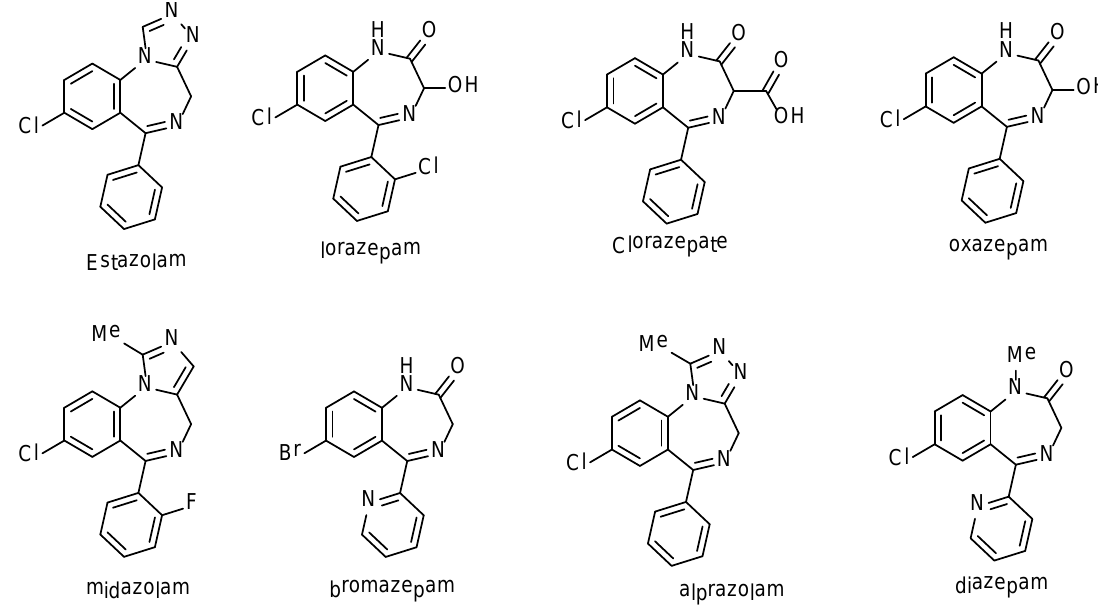
Figure 1. Representative examples of biologically active 1,4-benzodiazepines.